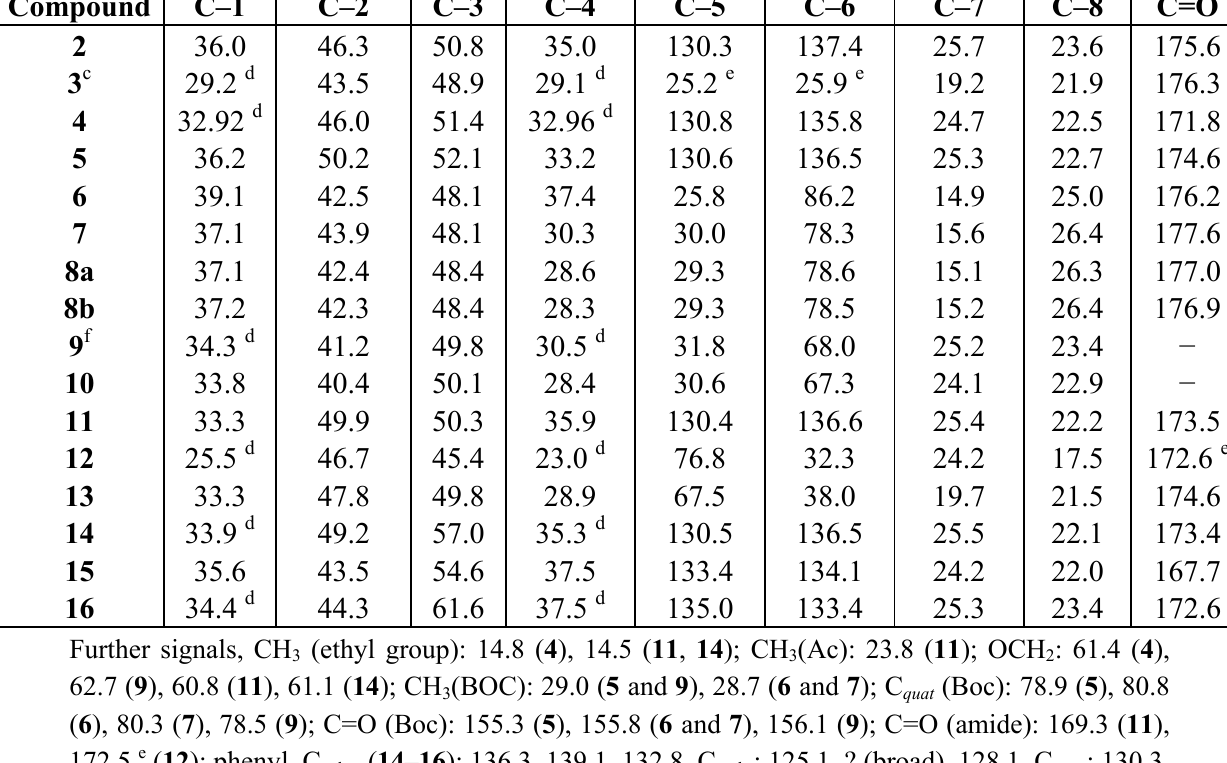
Table 2. 13 C-NMR chemical shifts a of compounds 2–7, 8a,b and 9–16 a,b